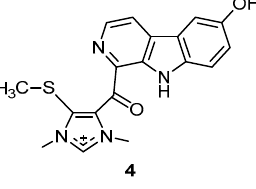
Figure 2. Chemical structure of hyrtiomanzamine ( 4 ).